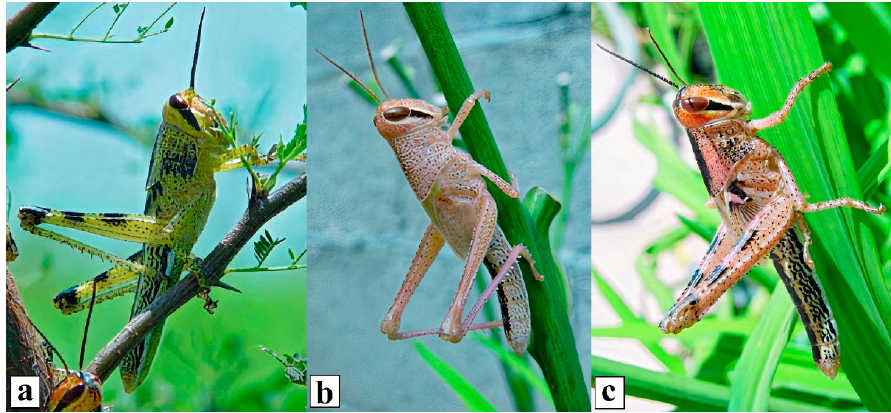
Figure 2. Central American locust, Schistocerca piceifrons piceifrons (Walker, 1870), solitarious ( a , b ) and gregarious ( c ) nymphs showing different color patterns.